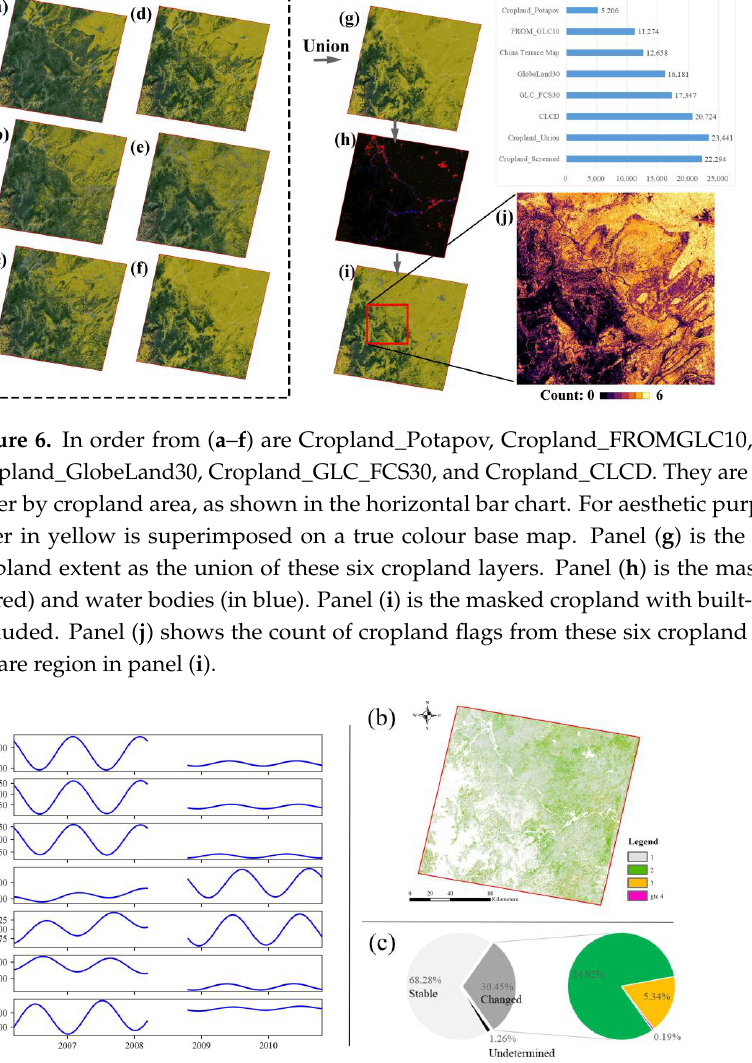
Figure 7. ( a ) An illustration of change detected by the CCDC algorithm. The pre- and post-change covers differ in temporal curves of spectral bands. ( b ) The spatial distribution of segment count, and ( c ) the structure of segment count. It reveals that 68% of croplands are stable, 25% undergo one disturbance or change, and 5.34% undergo two disturbances or changes.